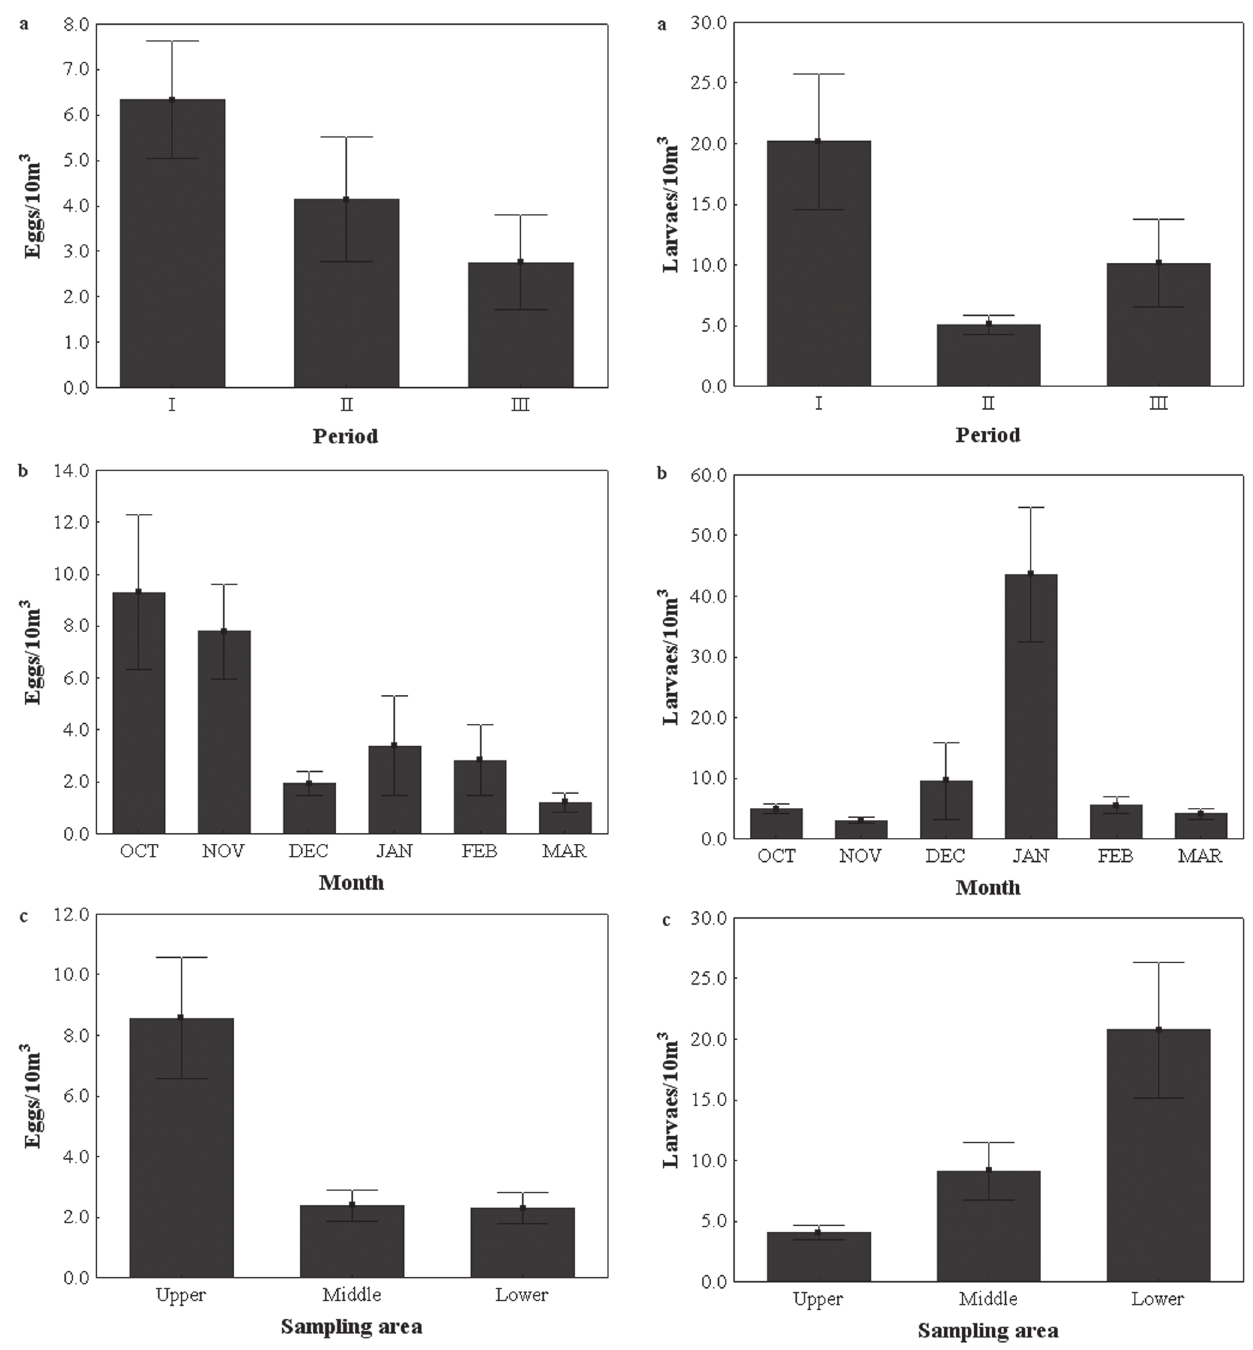
Fig. 2. Average egg abundances (rectangles) and standard errors (bars) by period ( a ), month ( b ) and sampling area ( c ) in the Ilha Grande National Park, from October 2001 to March 2005.